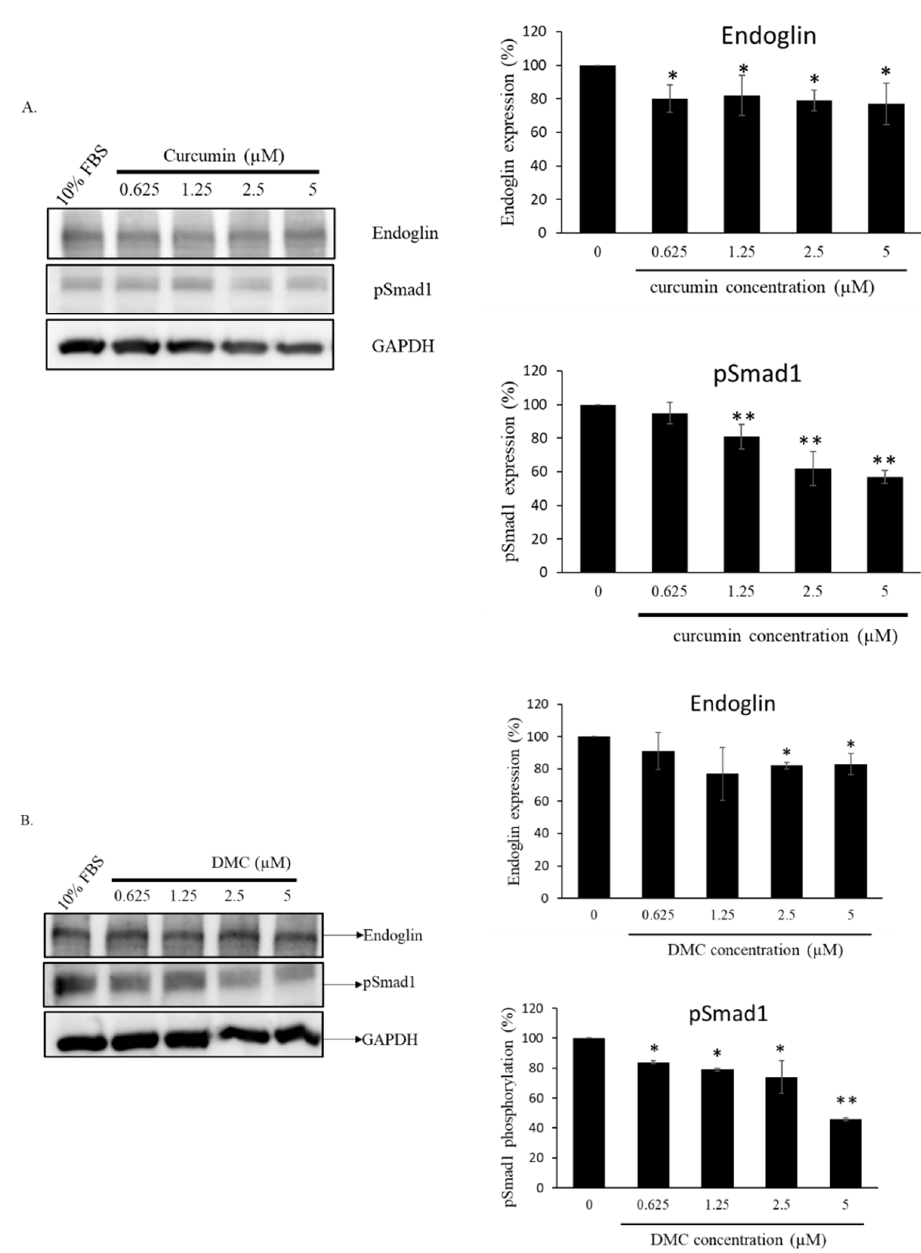
Figure 5. The inhibitory effects of curcuminoids (i.e., curcumin and DMC) on endoglin and phospho- rylation Smad1 in HUVECs in the long term (72 h.) ( A )Treatment with curcumin (0.625, 1.25, 2.5, and 5.0 µ M) and ( B ) DMC (0.625, 1.25, 2.5, and 5.0 µ M) substantially decreased endoglin expression and pSMAD1 phosphorylation. Endoglin expression and pSMAD1 phosphorylation were tested using Western blotting assays. * p < 0.05 and ** p < 0.01 compared to the control group (treated with 10% FBS